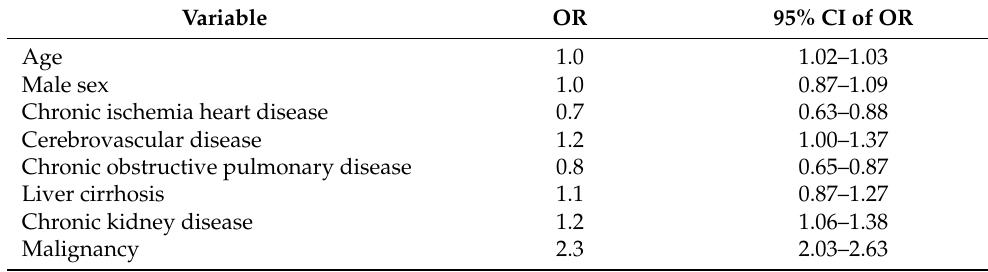
Table A2. Logistic regression analysis for the predictors of